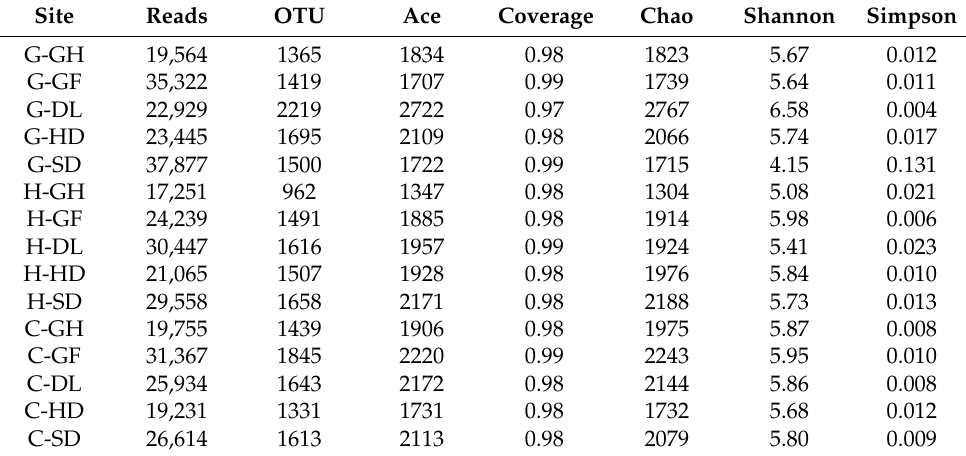
Table 2. Richness and diversity estimates for Illumina libraries from different habitats across 3 sites of soil sampled of cold-desert, Qinghai Tibet Plateau, China. CNH—CuoNaHu, HLH—HongLiangHe,